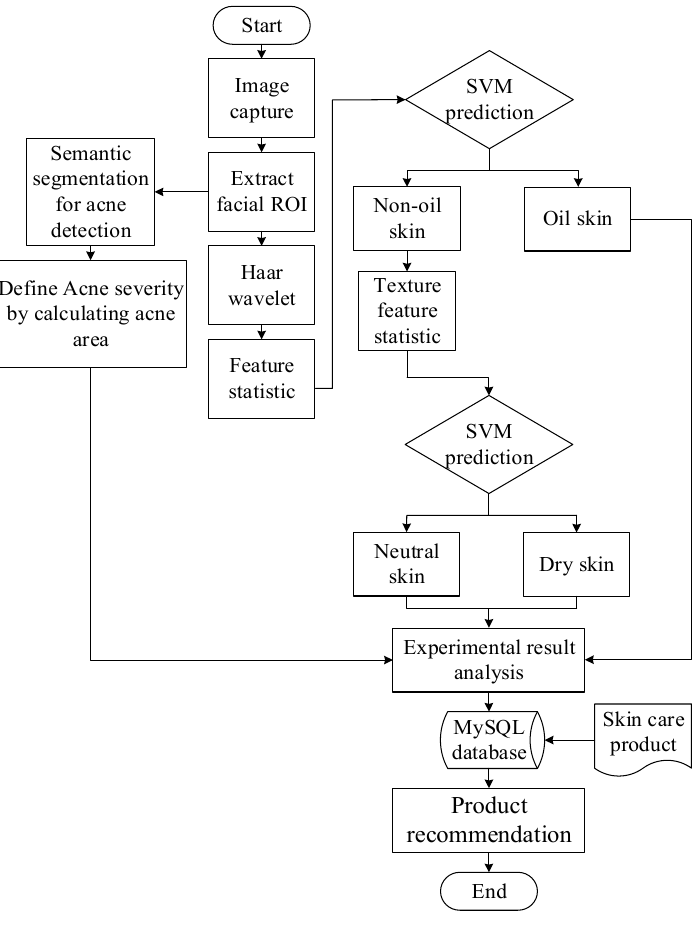
Figure 4. Flowchart of skincare products’ recommendation